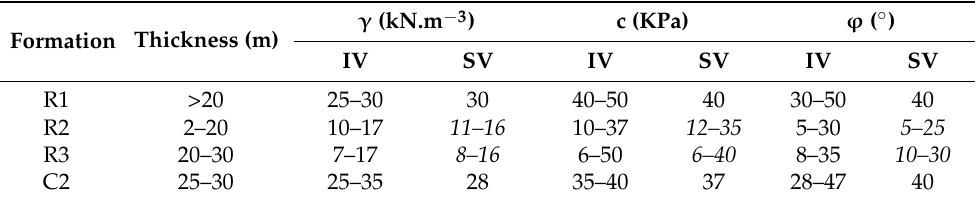
Table 5. Geotechnical values selected after sensitivity analysis for the La M é daille landslide. italic values are introduced as triangular probability distributions in ALICE ® .